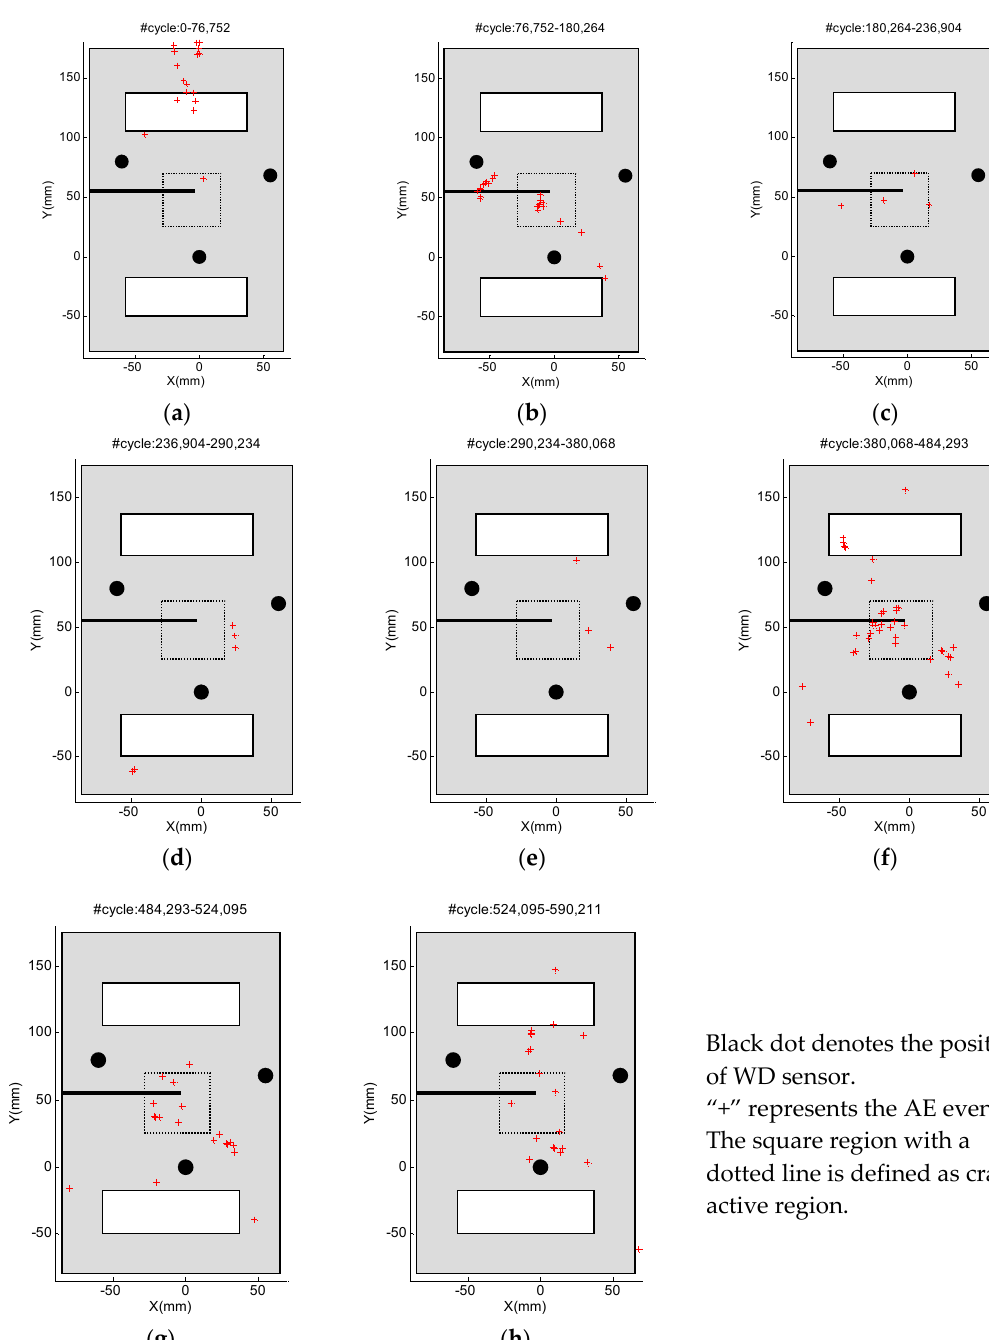
Figure 7. The AE event locations detected during the fatigue tests from day 1 to day 8: ( a ) day 1; ( b ) day 2; ( c ) day 3; ( d ) day 4; ( e ) day 5; ( f ) day 6; ( g ) day 7; and ( h ) day 8.